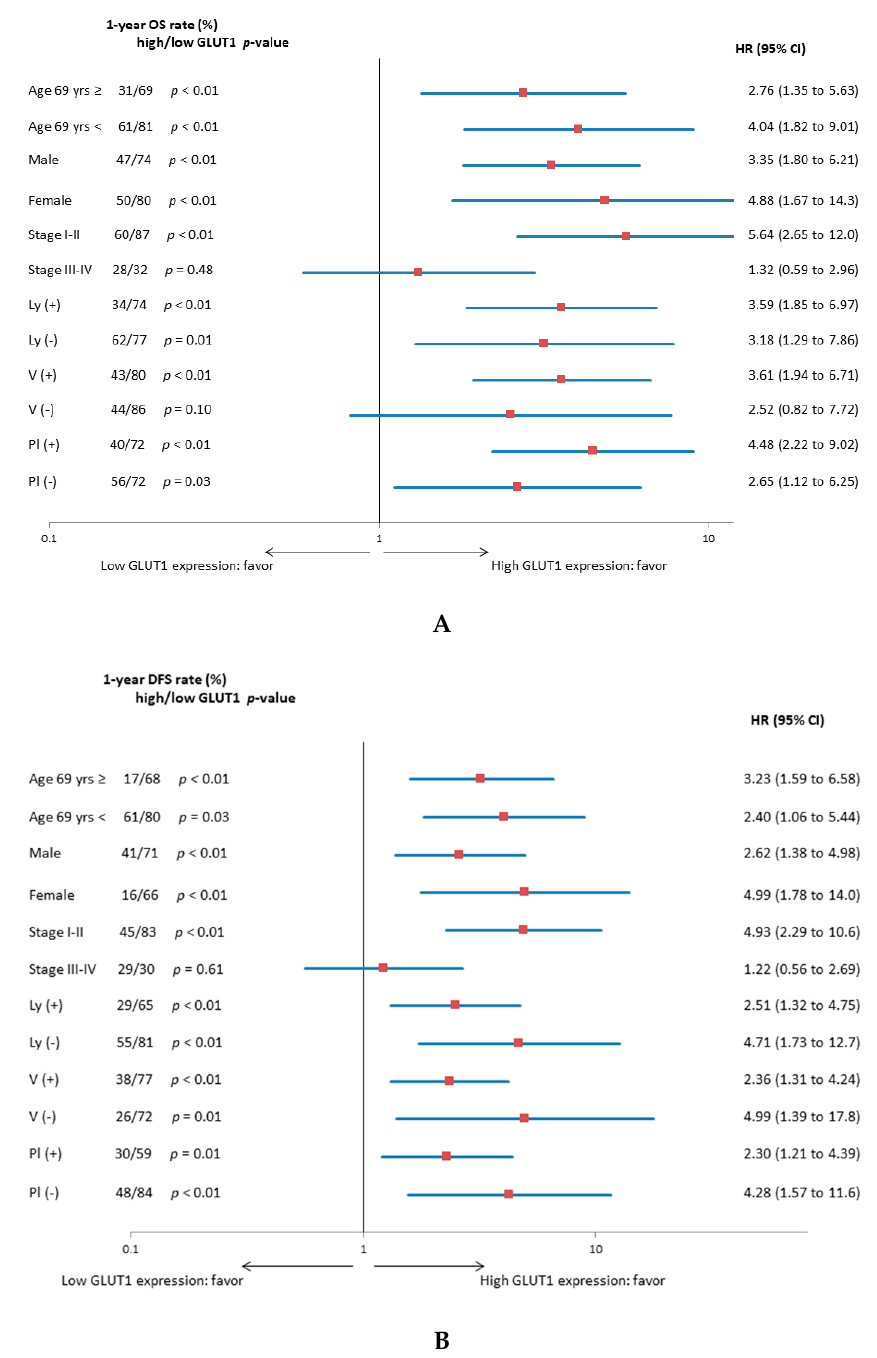
Figure 4. ( A ) Forest plot of one-year OS rate according to GLUT1 expression for each variable. ( B ) Forest plot of one-year DFS rate according to GLUT1 expression for each variable.